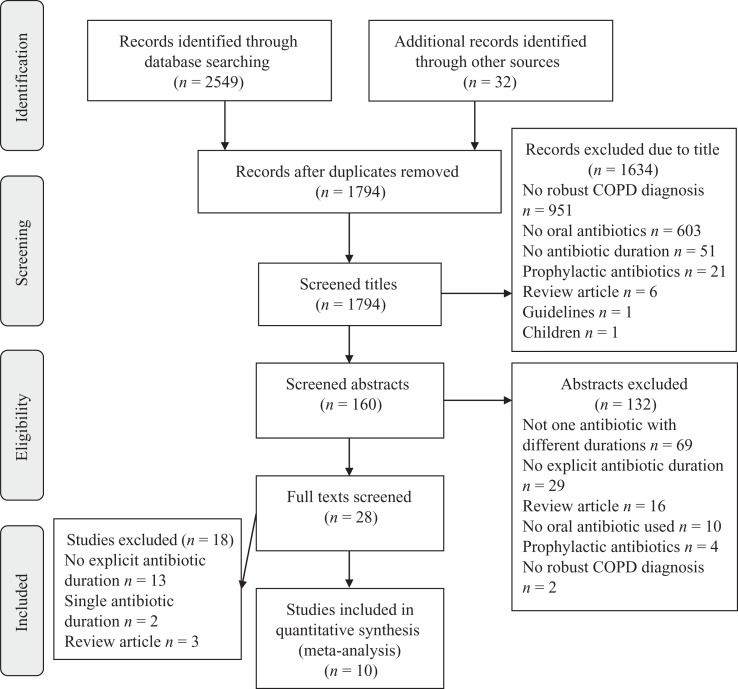
PRISMA flow diagram of systematic search for COPD studies. COPD: chronic obstructive pulmonary disease.